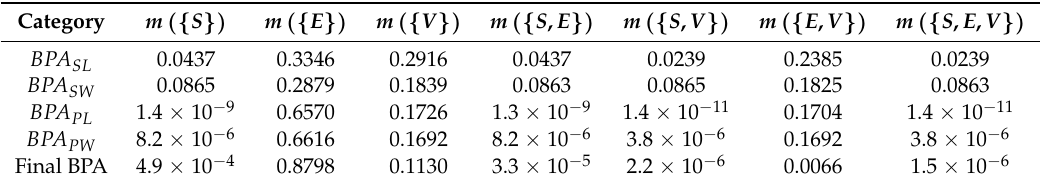
Table 3. BPA (basic probability assignment) under each attribute and final